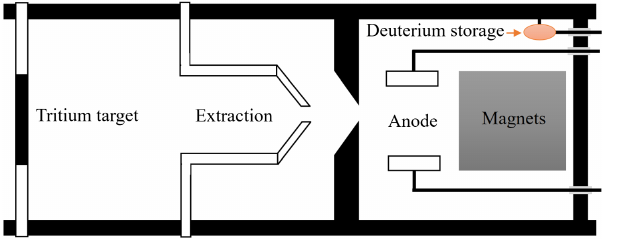
source.FIG. 1. The neutron tube structure diagram.